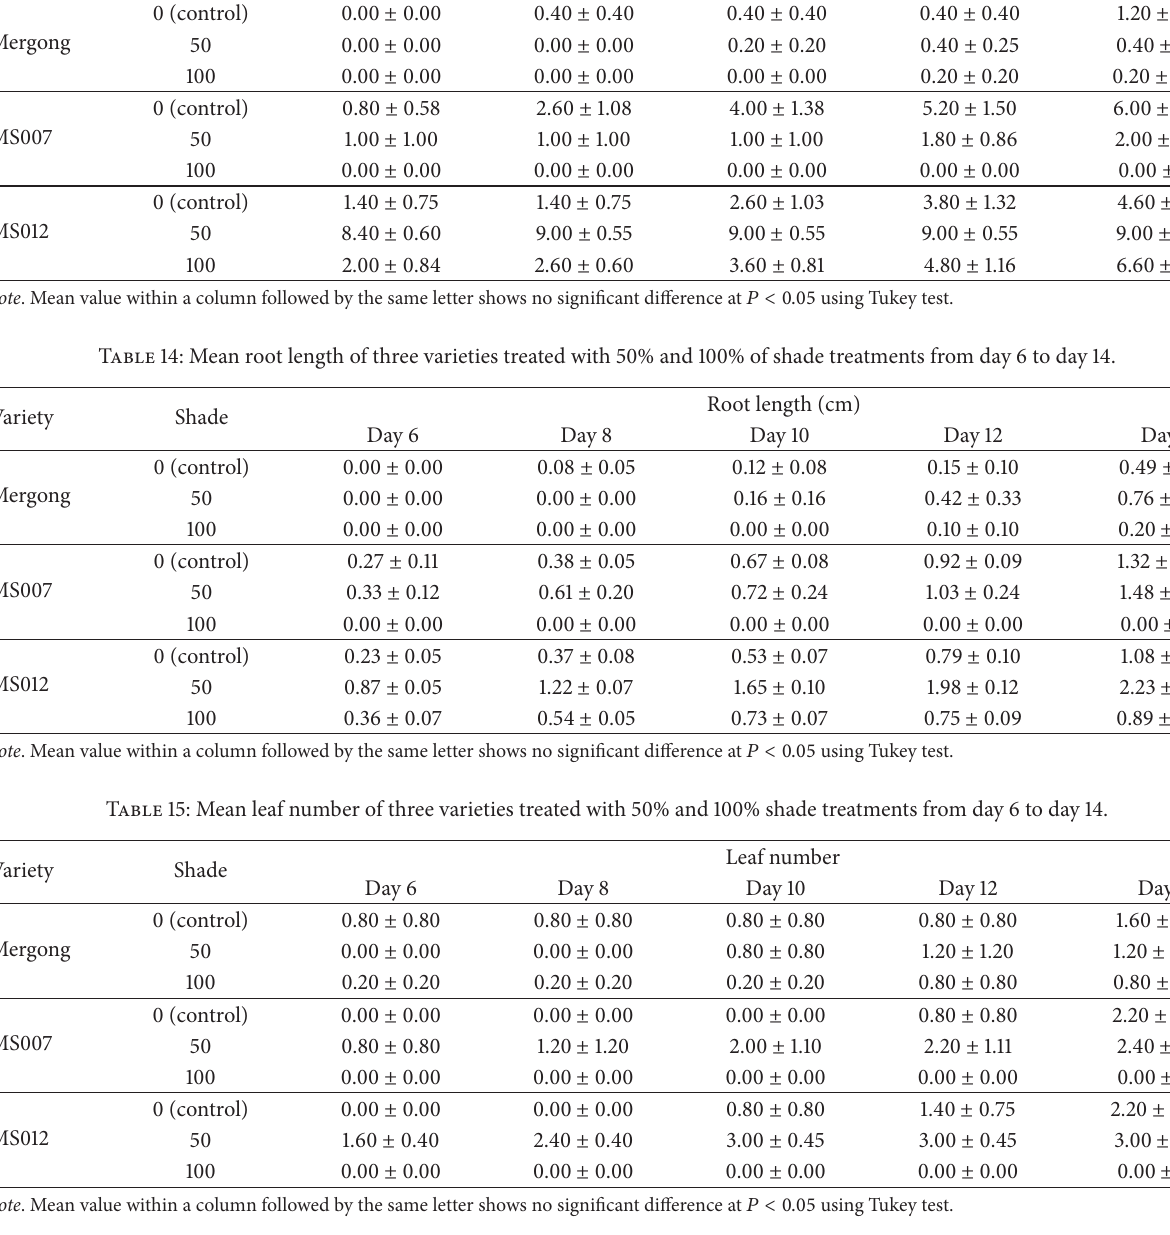
Table 13: Mean root number of three varieties treated with 50% and 100% of shade treatments from day 6 to day 14. Variety